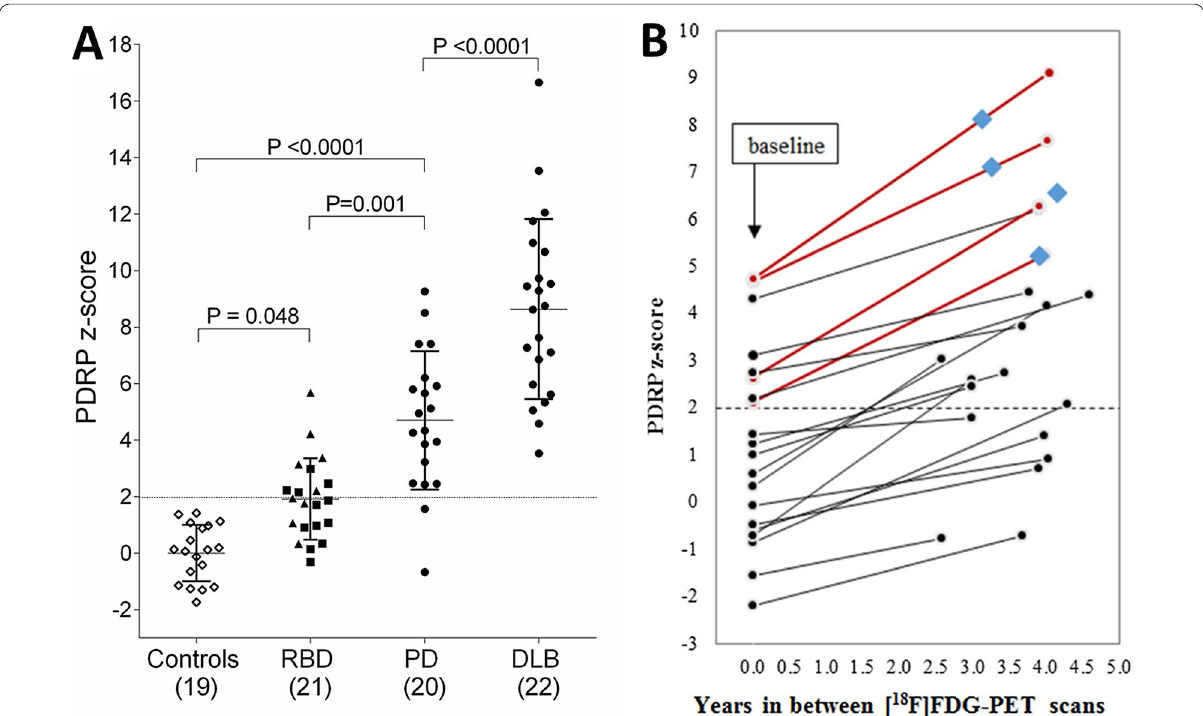
Fig. 2 A PDRP z-scores across groups. PDRP expression was calculated in all groups and z-transformed to the healthy controls. PDRP expression z-scores were compared across groups with a one-way analysis of variance. Post-hoc comparisons were Bonferroni-corrected. Triangles indicate patients with an abnormal DAT scan, squares indicate patients with a normal DAT scan. From: (Meles et al. 2017). The dashed line indicates z scores above this line are considered supra-threshold (see (Kogan et al. 2020)). B PDRP expression z-score changes between baseline and follow-up 18 F-FDG PET imaging in 20 iRBD patients. PDRP expression increased in all subjects. Four subjects (indicated by Burgundy lines), all with baseline significant PDRP z-scores, phenoconverted to clinical PD during the study. Diamonds denote point of clinical phenoconversion. From: (Kogan et al.